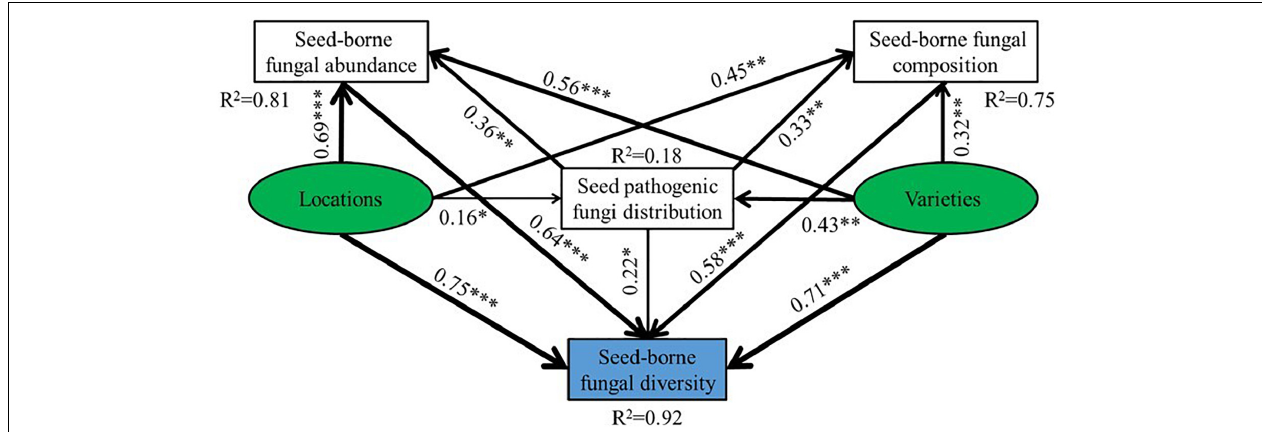
FIGURE 9 | Structural equation model (SEM) showed the effects of habitat and varieties on seed pathogenic fungi distribution, seed-borne fungal abundance, composition and diversity of oat. The arrows reflect the causal relationships, numbers close to lines are standardized path coefficients, the thickness of the black (positive) and red (negative) paths indicates the strength of the relationships, ∗ P < 0.05, ∗∗ P < 0.01, ∗∗∗ P < 0.001 (CFI = 0.994, RMSEA = 0.053, SRMR =